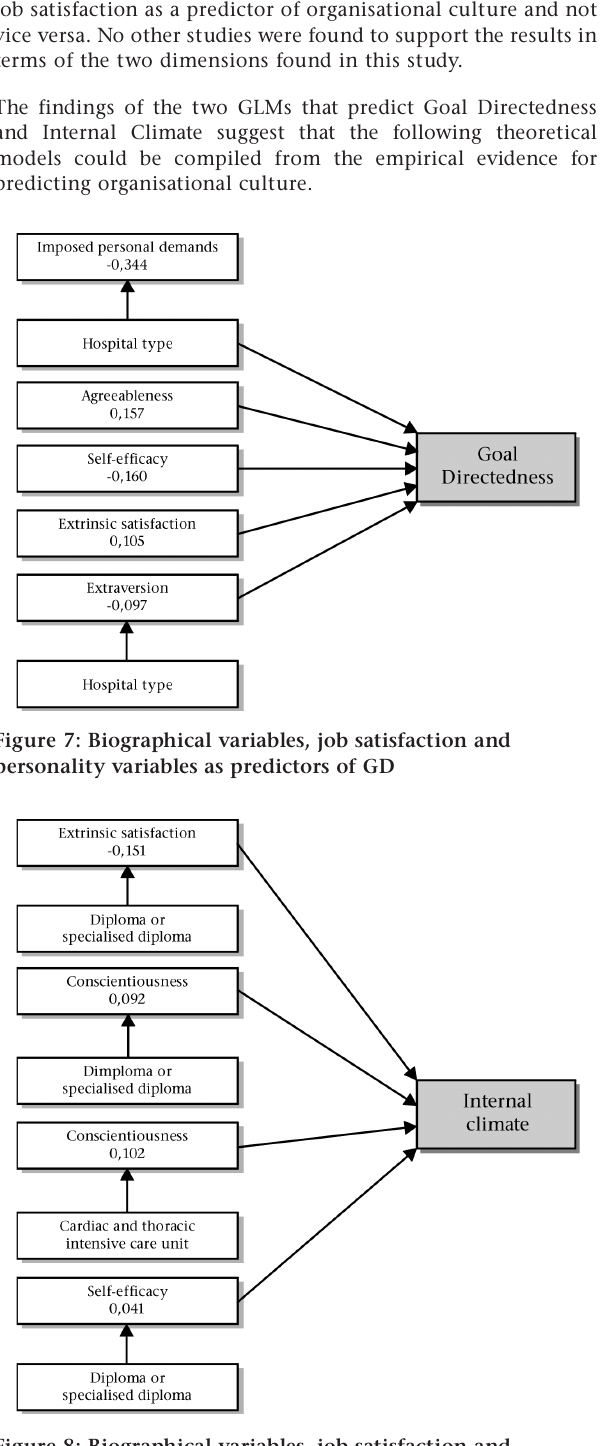
Figure 8: Biographical variables, job satisfaction